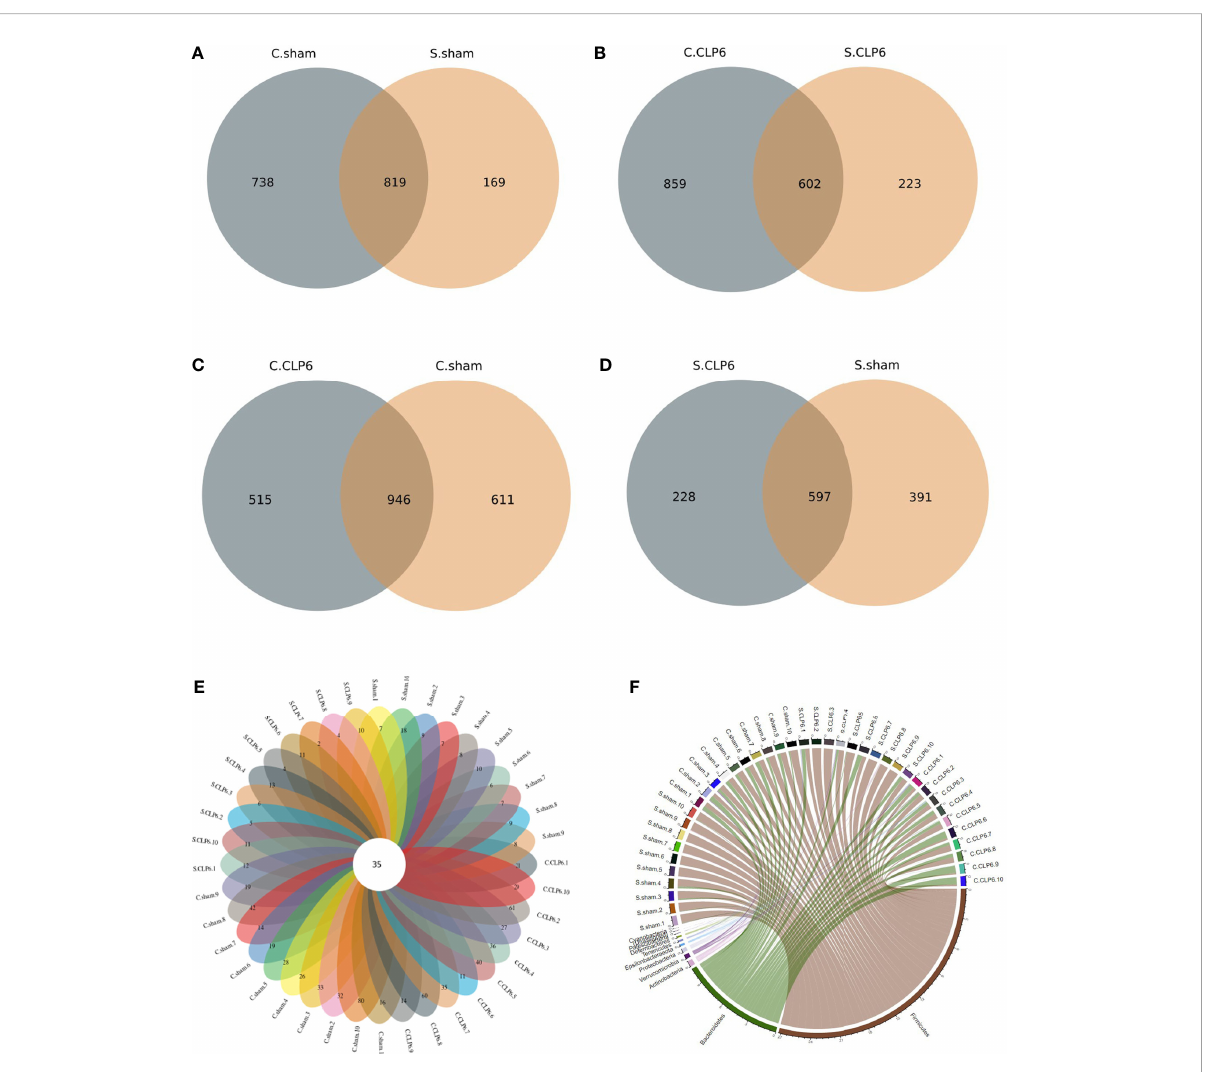
FIGURE 1 Distribution of gut microbiota in the two mouse groups [CLP6h group ( n = 10) and the sham group ( n = 10)]. (A) The number of unique gut microbiota species in the colon and small intestine in the sham group. (B) The number of unique gut microbiota species in the colon and small intestine in the CLP6h group. (C) The number of unique gut microbiota species in the colon in the sham group and CLP6h. (D) The number of unique gut microbiota species in the small intestine in the sham group and CLP6h. (E) The number of unique gut microbiota for every sample. The cross-section is the number of gut microbiota in common for every sample. (F) A chord diagram of the gut microbiota in the intestine of each sample. The circle diameter indicates the number of points; the greater the number is, the larger the diameter of the